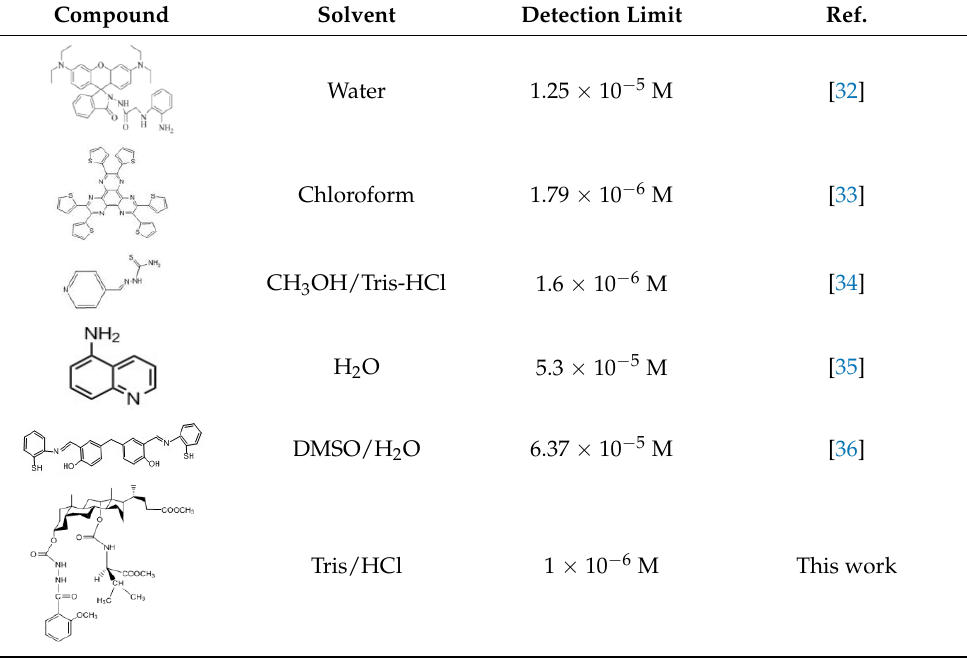
Table 3. Comparison of various recognition sensors for Ag + .